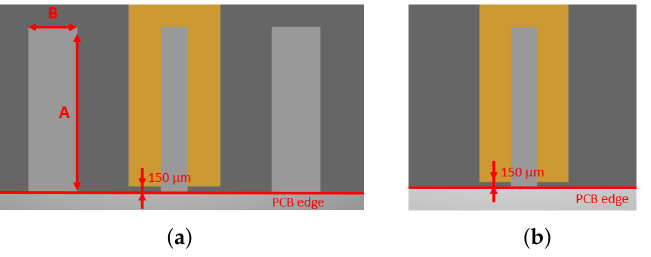
Figure 2. ( a ) PCB top view of signal launch used in PCB 1, PCB 2 and PCB 4. ( b ) PCB top view of signal launch used in PCB 3. The values for A and B are listed in Table 1. Table 1. Geometry and material parameters used for the test PCBs. The parameters L and H describe the length and the height of the PCB designs. All four designs are placed on the same PCB with a distance of 20 mm between each other. The overall PCB outline is 60 × 100 mm. The parameters A and B describe the dimensions of the top ground landing pads (see Figure 2a). PCB 3 does not use top ground landing